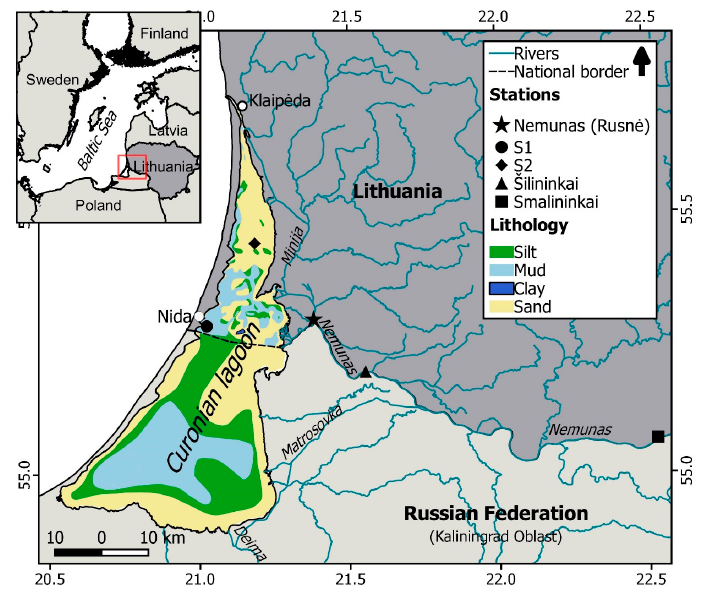
Figure 1. The study site with the calibration stations and bottom sediments in the Curonian Lagoon (the bottom sediment data acquired after [31,32]). The Curonian Lagoon is a terrestrial runoff ‐ dominated system, with its hydrology strongly related to the discharge of its catchment area. The main rivers which enter the lagoon are Nemunas (Neman), Minija, Deima, and Dan ė . The total drainage area of the Curonian Lagoon is 100,458 km 2 and covers four countries: Belarus (48%), Lithuania (46%), and 6% lies in Kaliningrad Oblast of Russia and Poland together [33]. The catchment area of Nemunas river only is 98,200 km 2 (47.5% in Lithuania) and on average brings about 21.8 km 3 of water per year to the lagoon (~700 m 3 s − 1 calculated for the monitoring station Smalininkai, about 112 km from the river mouth) [34]. The Nemunas River enters the lagoon in the middle of the eastern coast and, every year, carries a big amount of fresh water that exceeds the water volume of the lagoon itself by about 3.6 times. Therefore, the southern and central parts of the lagoon are freshwater (average annual water salinity